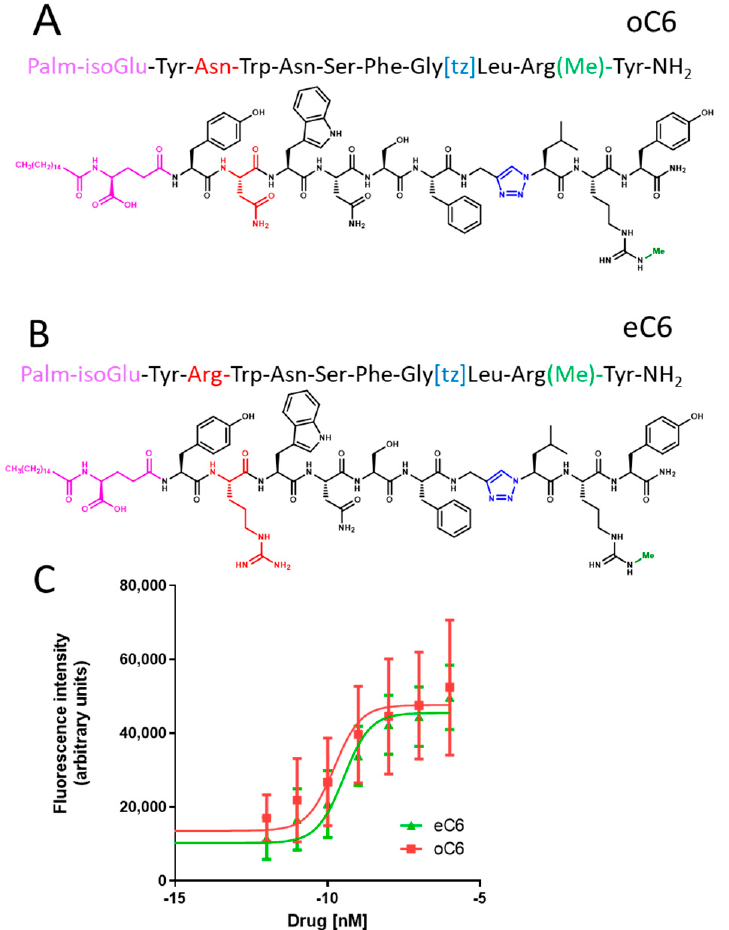
Figure 2. Structures of oC6 and eC6 and comparison of their in vitro activity. The chemical structures of oC6 and eC6 are shown in panel ( A , B ), respectively. In red is shown the amino acid that differentiates the ovine and the equine Kp10 sequences. The other colored parts are the chemical modifications introduced into the Kp10 structure: in violet the N-palmitoylated- γ -glutamate in the N-terminal position, in blue the triazole that substitutes the peptide bond between the Gly7 (Kp10 numbering) and the Leu8, and in green the methyl group that has been added to the Arg9. The graph ( C ) shows the concentration activity response of oC6 and eC6 in a calcium mobilization assay performed on HEK-293 cells stably transfected with the human